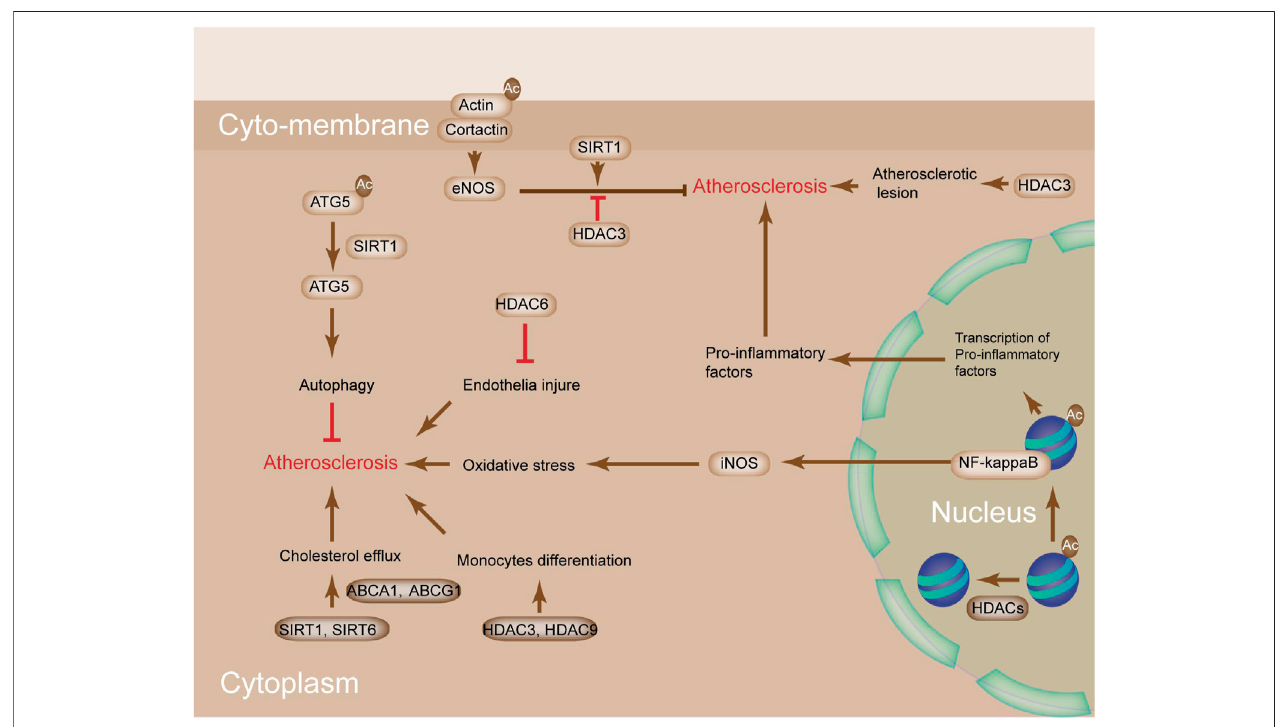
FIGURE 4 | The potential mechanism of HDACs in atherosclerosis. SIRT1 and SIRT6 perturbation promotes cholesterol ef fl ux by activating ABCA1 and ABCG1, leading to reduced macrophage-derived foam cell formation. Deacetylation of ATG5 by SIRT1 activates ATG5 to increase autophagy, which protects from AS. SIRT1- mediated deacetylation of cortactin promotes the translocation of cortactin to the cell periphery, whereas its interaction with cortical actin activates eNOS under shear stress conditions, which increases the bioavailability of nitric oxide (NO) and protects from AS. HDAC3/9 are stimulated in response to monocyte differentiation to macrophages in LDLR − / − mice kept on an atherogenic diet. HDAC6 is implicated in the prevention of endothelial injury and AS. NO bioavailability is increased by SIRT1- mediated deacetylation of eNOS and decreased by HDAC3-mediated deacetylation of eNOS. Acetylation of NF- κ B subunits activates the expressions of Nos1, Nos2, and pro-in fl ammatory genes. High levels of NO and oxidative stress promote